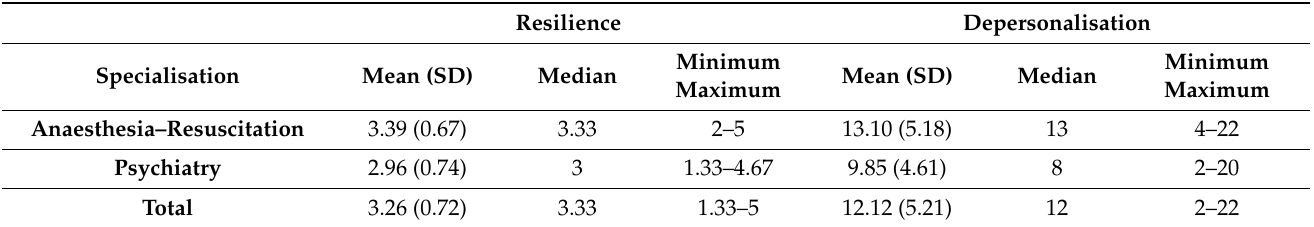
Table 6. Mean standard deviation and the median, minimum and maximum values of resilience (BRS) and depersonalisation in anaesthesia–resuscitation and psychiatry